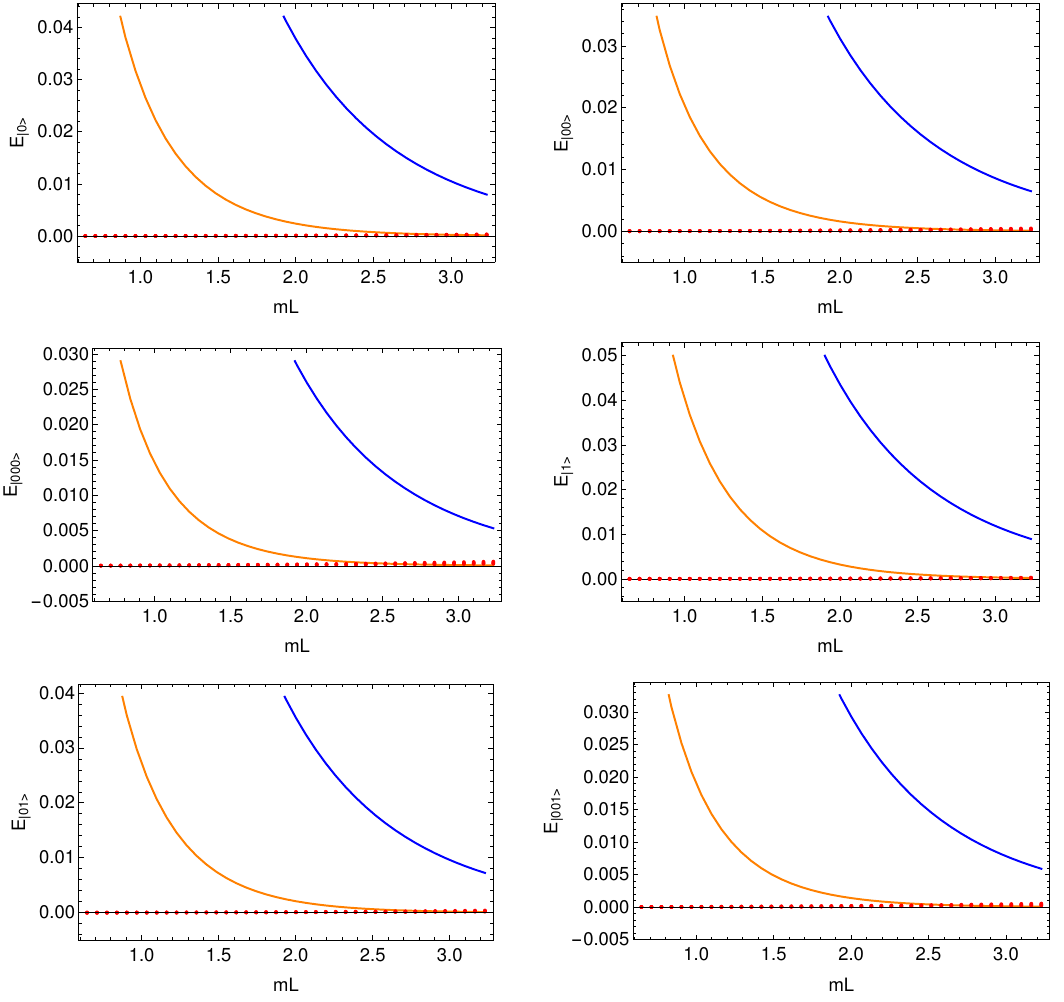
Figure 5 . Volume dependence of the energy of some relevant low-lying states in sinh-Gordon model at b = 1. Again, TBA data are subtracted from each data set. TCSA data is shown by red dots. The di(cid:11)erence between the BY lines and TBA (blue) and between BY+leading L(cid:127)uscher and TBA (orange) are also indicated. Once again, we see reassuring agreement between the TBA and TCSA data (the di(cid:11)erence being close to 0, as